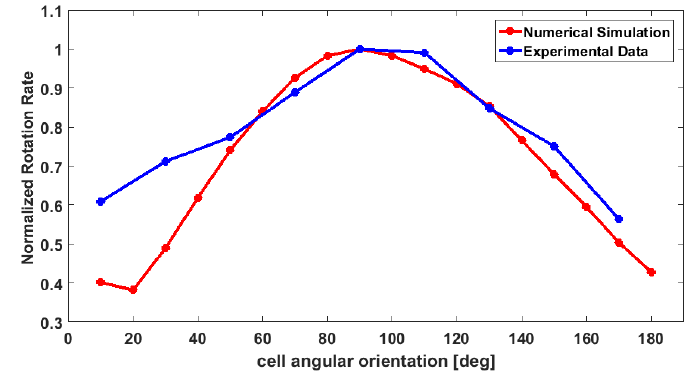
Figure 9. The plot shows the rotation rate (number of rotation/s) in relation to the cell angular orientation both for the experimental and simulation data.